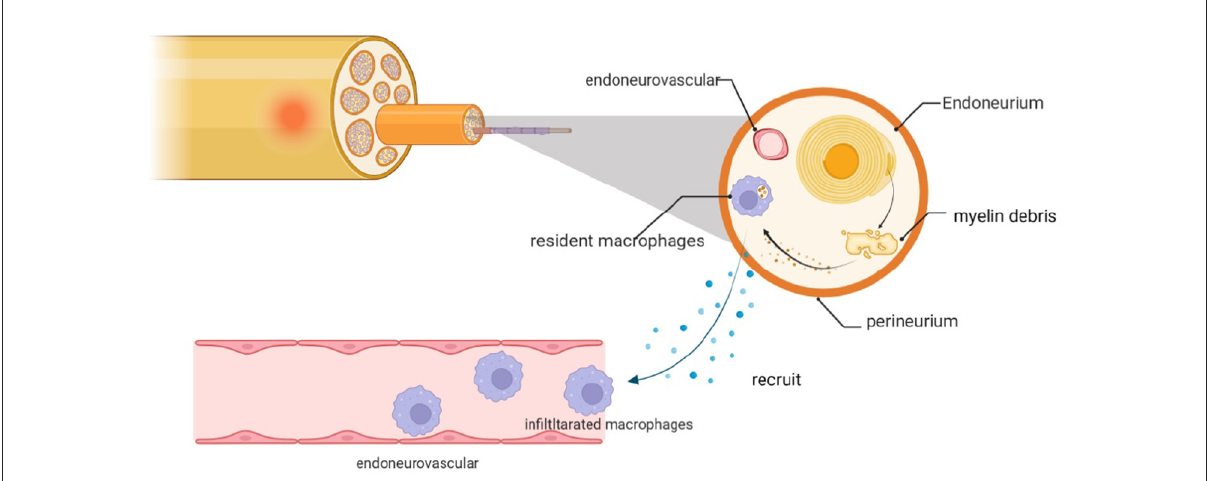
FIGURE4 Myelin debris that accumulates after PNI is cleared by macrophages, including resident cells and those recruited locally from the neurovasculature. The infiltrating macrophages are recruited in response to chemokines and cytokines that are expressed by dedifferentiated SCs and resident